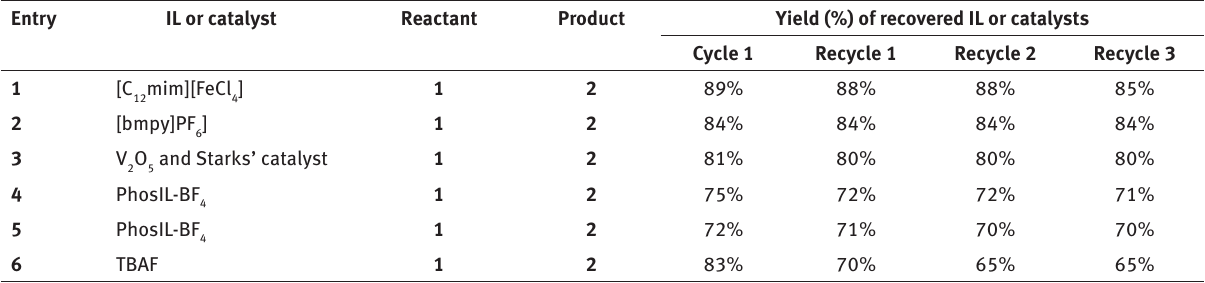
Table 2: Efficiency of recycled ionic liquids or catalysts in synthesis of